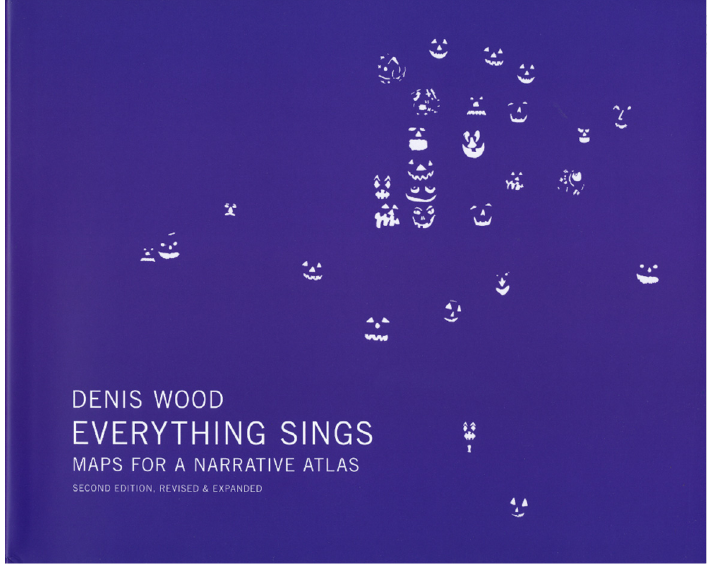
Figure 2. Cover of Everything Sings ([5], used with